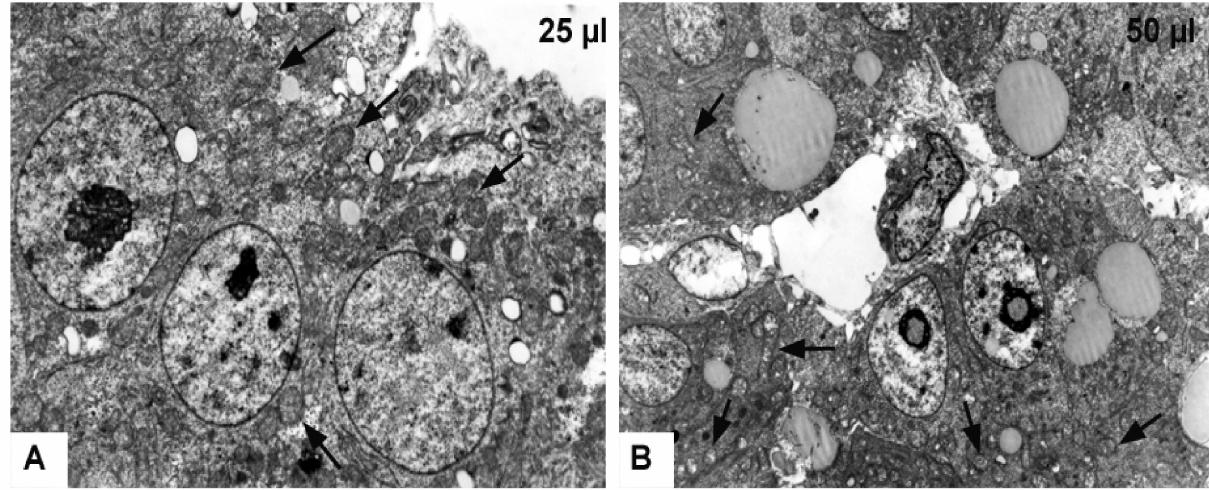
Figure 8. Transmission electron microscopy of the chicken developing liver. ( A ): Experimental group—25 µ L of DMSO administration, magnification: 8800 × ; ( B ): Experimental group—50 µ L of DMSO administration, magnification: 4400 × ; arrows—slightly dilated mitochondria ( A ), fragmented cristae of mitochondria with electron-lucent matrix ( B